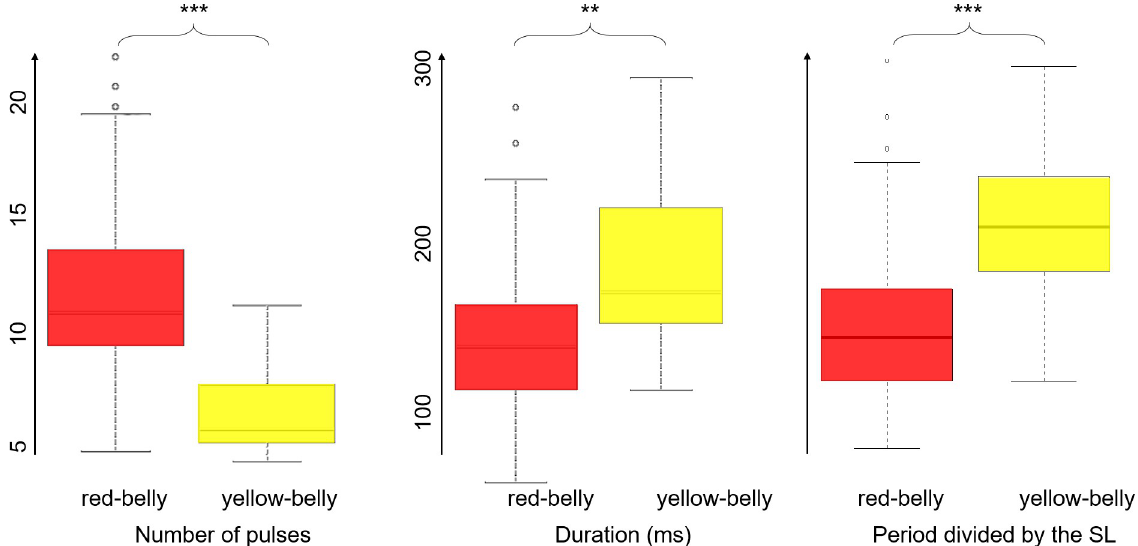
Fig 6. Comparison of acoustic features of red and yellow-bellied Pygocentrus nattereri . Boxes represent the median ± interquartile range (IQR) and lines represent Q1–1.5 IQR and Q3 + 1.5 IQR. �� = P < .01; ��� P < .001; Wilcoxon-Mann-Whitney.